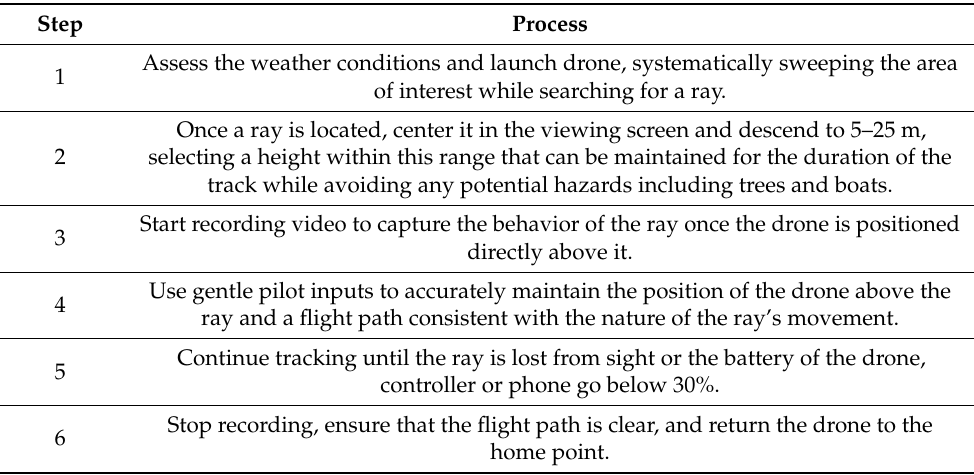
Table 1. Detailed protocol for the drone-based ray tracking methodology